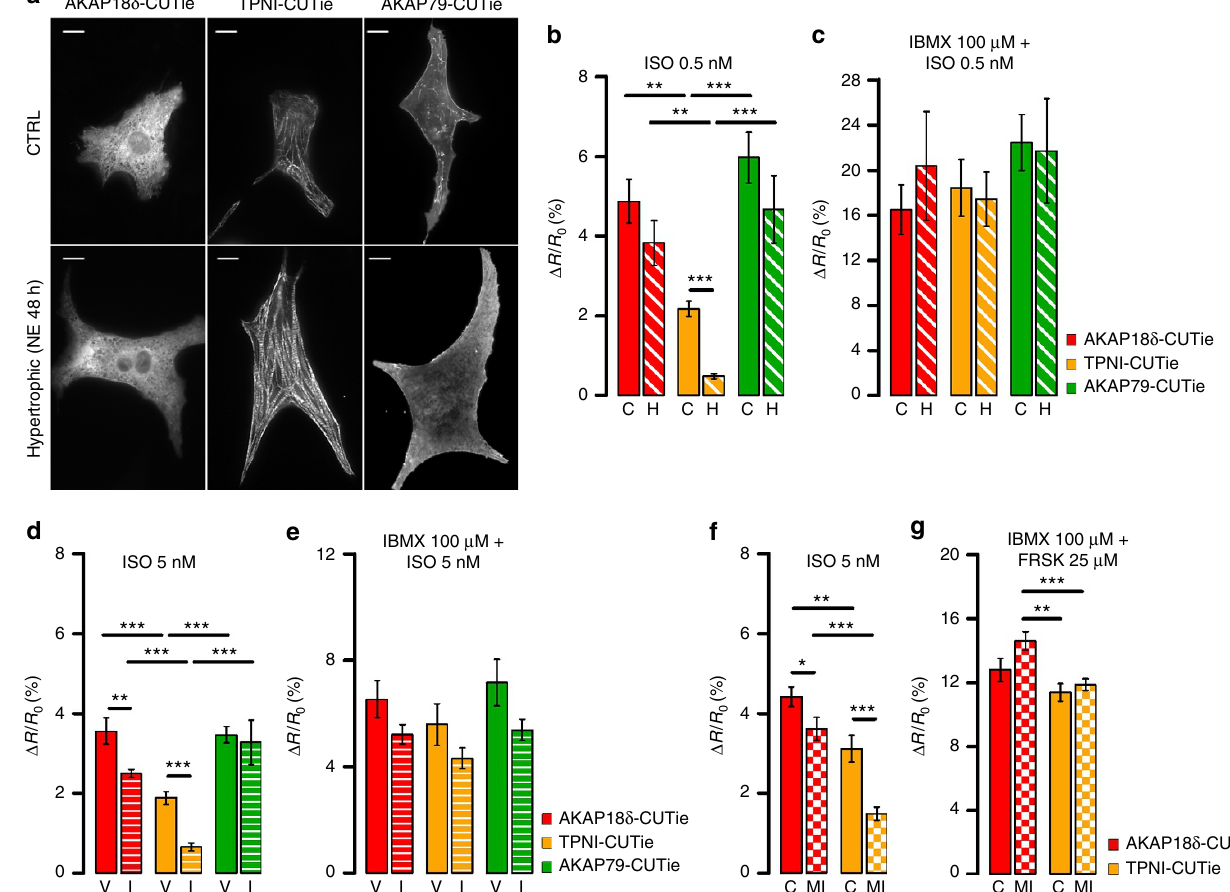
Figure 6 | Compartmentalized cAMP signalling in hypertrophic cells. ( a ) Localization of the targeted CUTie reporters in control (top) and hypertrophic (bottom) NRVM. Scale bar: 10 m m. Average cell size for control myocytes was 351.8 ± 7.3 m m 2 and for hypertrophic myocytes 674.9 ± 14.8 m m 2 ( N Z 216 cells from five biological replicates, P r 0.001). ( b ) Mean FRETchange measured with targeted CUTie reporters in control (C) and hypertrophic (H) NRVM on application of 0.5nM ISO and ( c ) 0.5nM ISO in the presence of 100 m M IBMX. N Z 6 from five biological replicates. ( d ) Mean FRETchange measured with targeted CUTie reporters in isolated ARVM from minipump vehicle- (V) and ISO-infused (I) rats, on application of 5nM ISO and ( e ) 5nM ISO in the presence of 100 m M IBMX. N Z 8 from at least six biological replicates. Bars indicate means ± s.e.m. Unpaired t -test. ( f ) Mean FRETchange measured with targeted CUTie reporters in isolated ARVM from age-matched control (C) and rats subjected to myocardial infarction (MI) at 16 weeks after coronary artery ligation, on application of 5nM ISO and ( e ) saturating stimulus. N Z 16 from at least seven biological replicates. In all graphs bars indicate means ± s.e.m. Unpaired t -test applied for comparison between treatment groups, one-way ANOVA and Bonferroni’s post hoc test for comparison